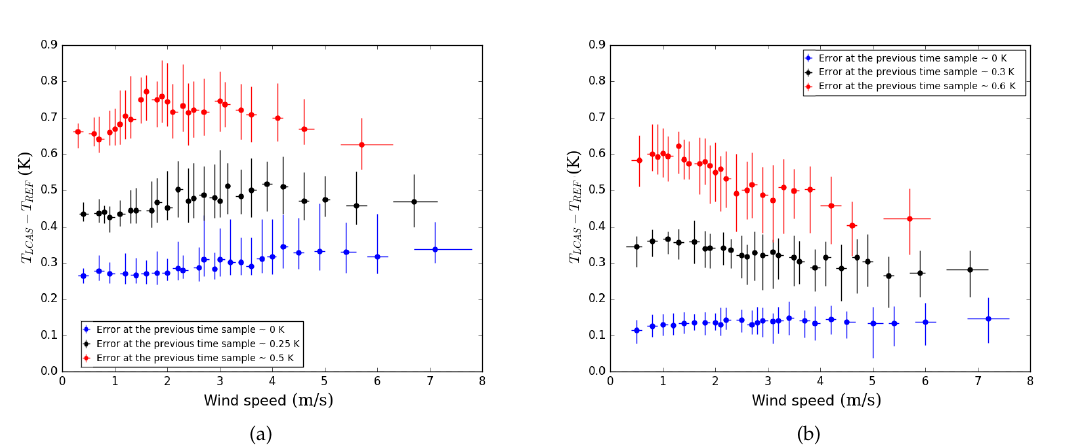
Figure 8. Evolution of the error within LCAS shelter against the wind speed for several (cid:101) T ( t − ∆ t ) values ( a ) for negative heating rate ( ˙ T ∼− 1.2 K · h − 1 ) and ( b ) for positive heating rate ( ˙ T ∼ 1.2 K · h − 1 ). Please note that each dot/error bars represents the median/quartiles values of a 5-percentile interval of wind